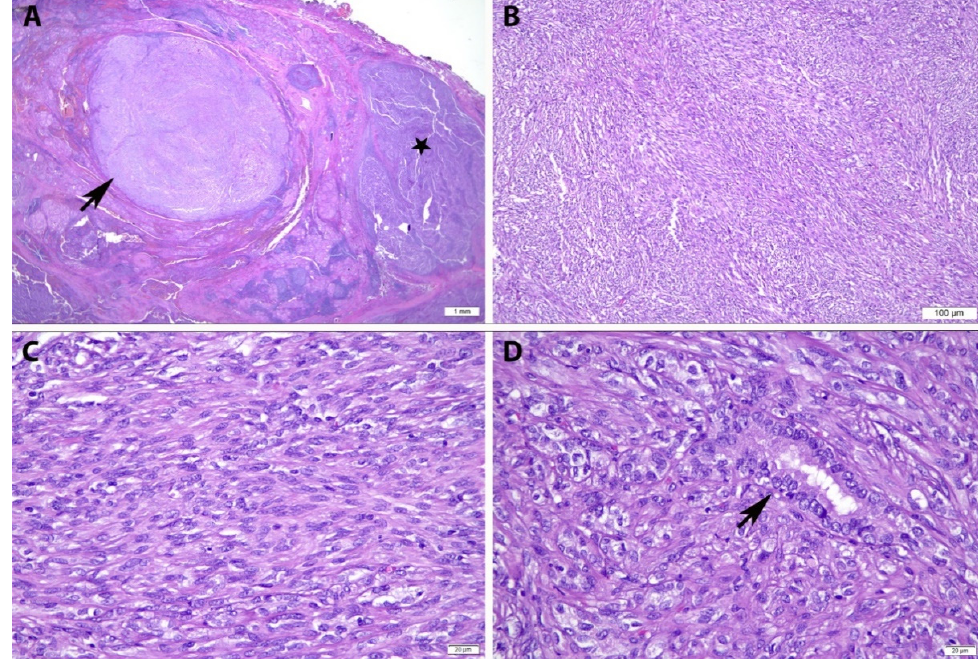
Figure 2. Histopathological Features of Papillary Thyroid Carcinoma with Spindle Cell Metaplasia. ( A ) A well circumscribed nodule (arrow) with adjacent tumour tissue displaying classical PTC (black star) (H&E, ×12.5); ( B ) The nodule comprises of spindle cells arranged in loose fascicles devoid of papillary architecture (H&E, ×100); ( C ) At a higher magnification, the spindle cells display uniform, plump to thin elongated nuclei with relatively abundant eosinophilic cytoplasm. No nuclear grooves and intranuclear cytoplasmic pseudoinclusions are found. No increase in mitosis nor necrosis is noted (H&E, ×400); ( D ) Entrapped tumour cells within the nodule exhibiting features consistent with classical PTC (arrow) are also observed (H&E, ×400).